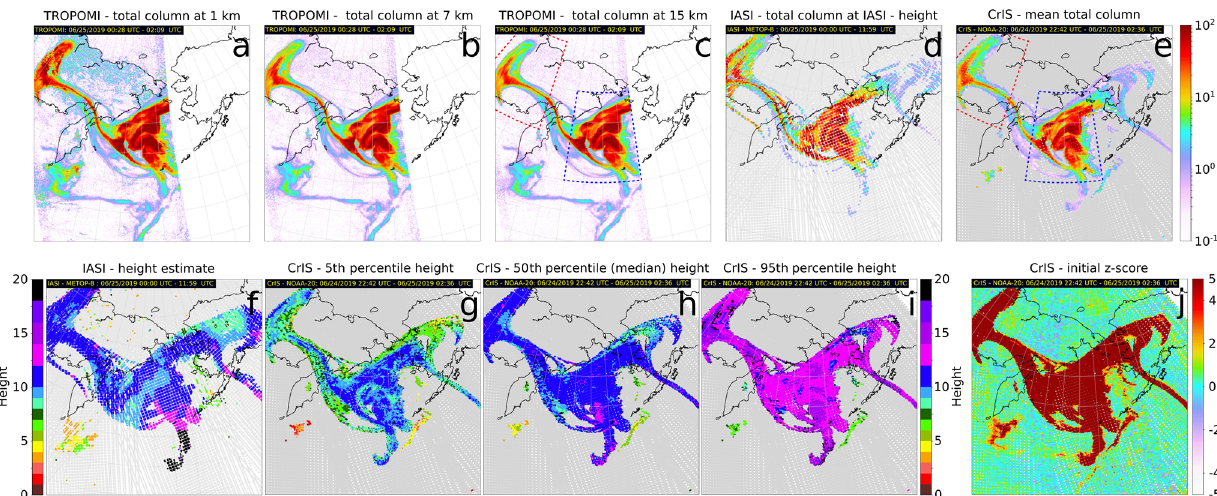
Figure 9. Representative comparison between TROPOMI, IASI, and CrIS SO 2 data. TROPOMI VCD given a 1km thick layer at 1km (a) , 7km (b) , and 15km (c) altitudes; IASI (METOP-B) VCD given a 1km thick layer at the IASI height estimate (f) ; and CrIS (NOAA-20) mean total VCD (integrated against the height PDF). IASI height estimate (f) ; CrIS 5th (g) , 50th (median, h ), and 95th (i) percentile heights; and CrIS initial z score (j) . The CrIS–TROPOMI comparison regions analyzed in Fig. 10 are shown in panels (c) and (e) as outlined dashed red and blue latitude–longitude